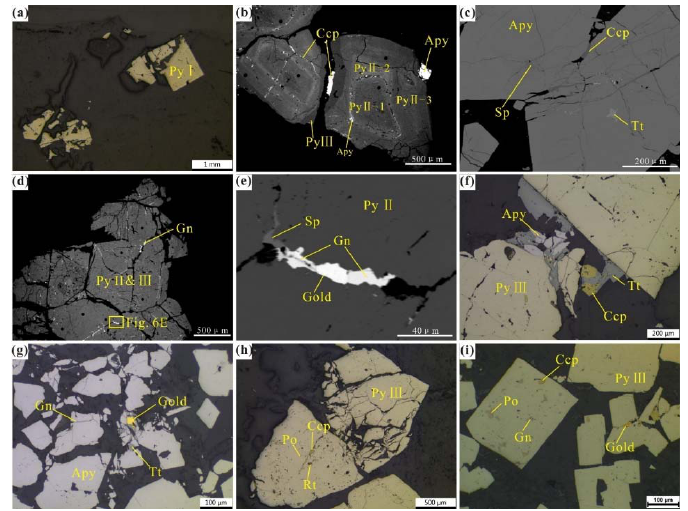
Figure 6. Photomicrographs showing textures and features of metal minerals in Zhengchong gold deposit: ( a ) Reflected light image of isolated gold-barren PyI showing a fractured or corroded pyrite crystal. ( b ) BSE image of oscillatory zonation of PyII; lighter bands are As-rich. Arsenopyrite and tetrahedrite occur in pores of PyII-2. Chalcopyrite fills the fractures of PyII or occurs as overgrowth on PyIII in a quartz-carbonate vein. ( c ) BSE image of chalcopyrite and sphalerite cross-cutting arsenopyrite. ( d ) BSE image of galena filling the fracture of cataclastic pyrite. Sample 290-7